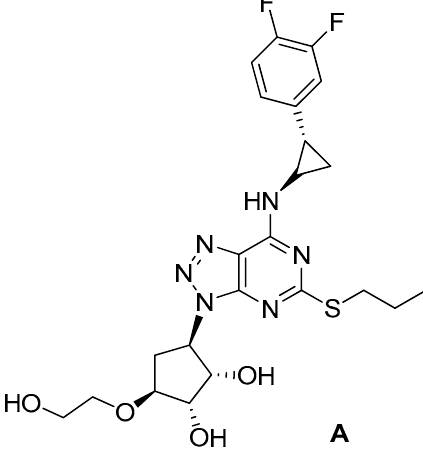
Figure 1. Chemical structure of ticagrelor.